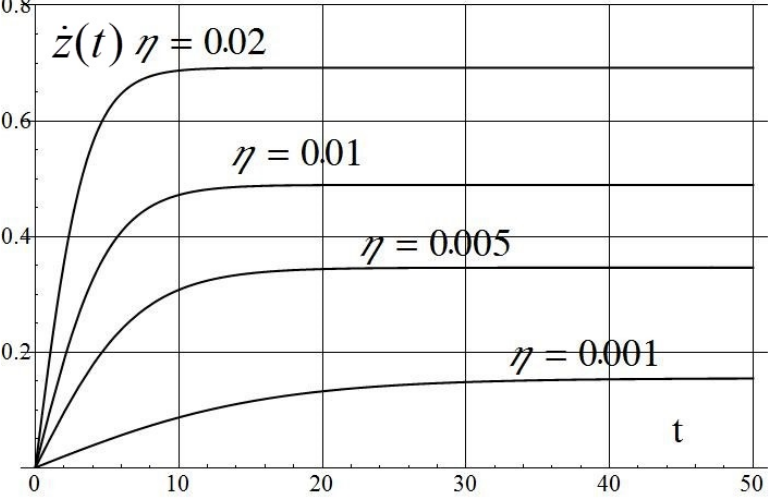
Figure 2. Speed of submersion of the cylinder versus time in accelerated motion for an instantaneous change in buoyancy ( t 0 = 0 ) and various magnitudes of η , l c = 1